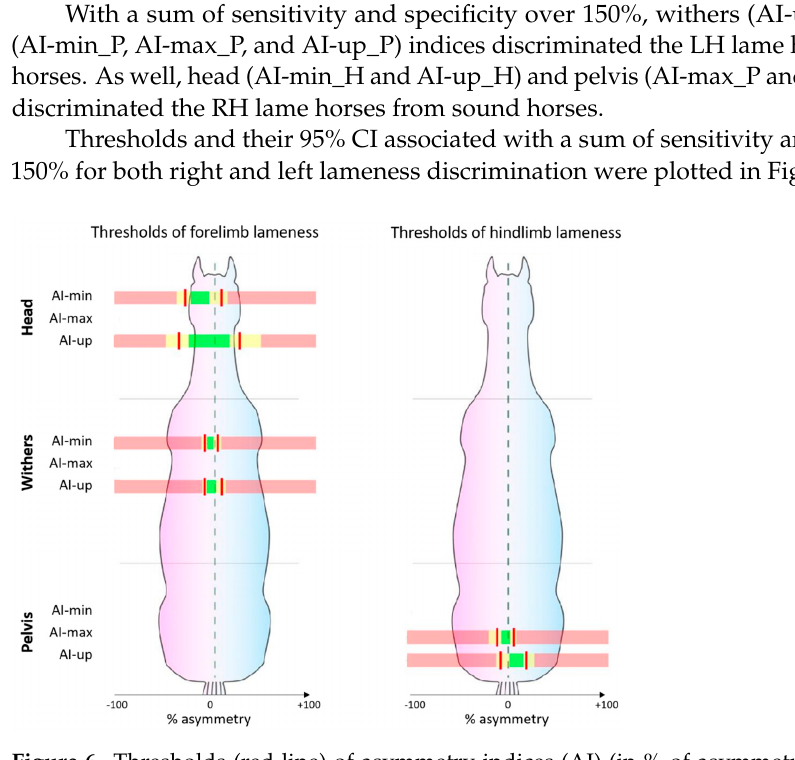
Figure 6. Thresholds (red line) of asymmetry indices (AI) (in % of asymmetry) for forelimb and hindlimb lameness discrimination. Only the AIs with the sum of sensitivity and specificity over 150% for both right and left lameness are plotted. Three range of values are represented: yellow for 95% confidence interval (95% CI) around the threshold, green for values below the 95% CI (“sound” horses) and red for values beyond the 95% CI (“lame” horses).